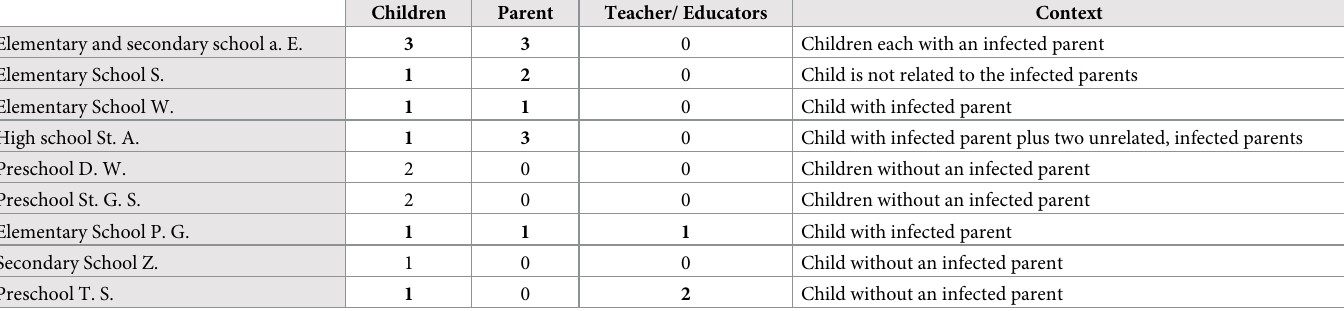
Table 6. Facilities which the IgG-positive children attended, with associated IgG-positive parents and number of IgG-positive teachers/educators working in each facility. Children Parent Teacher/ Educators